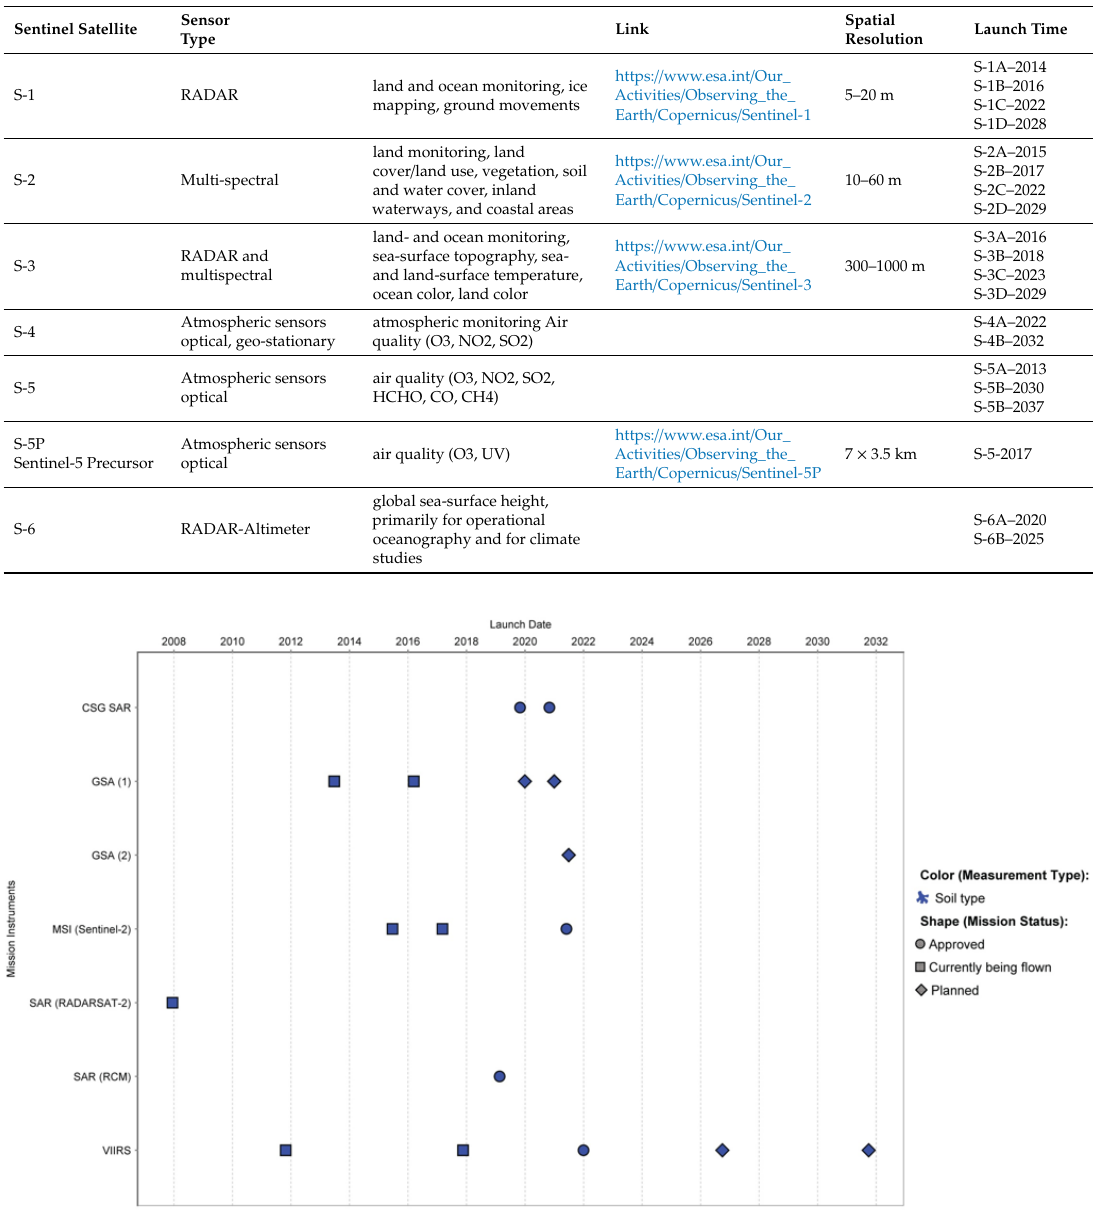
Table 3. Current and future important missions of the Copernicus program – Sentinel satellites for derivation of geodiversity and their traits developed by ESA.